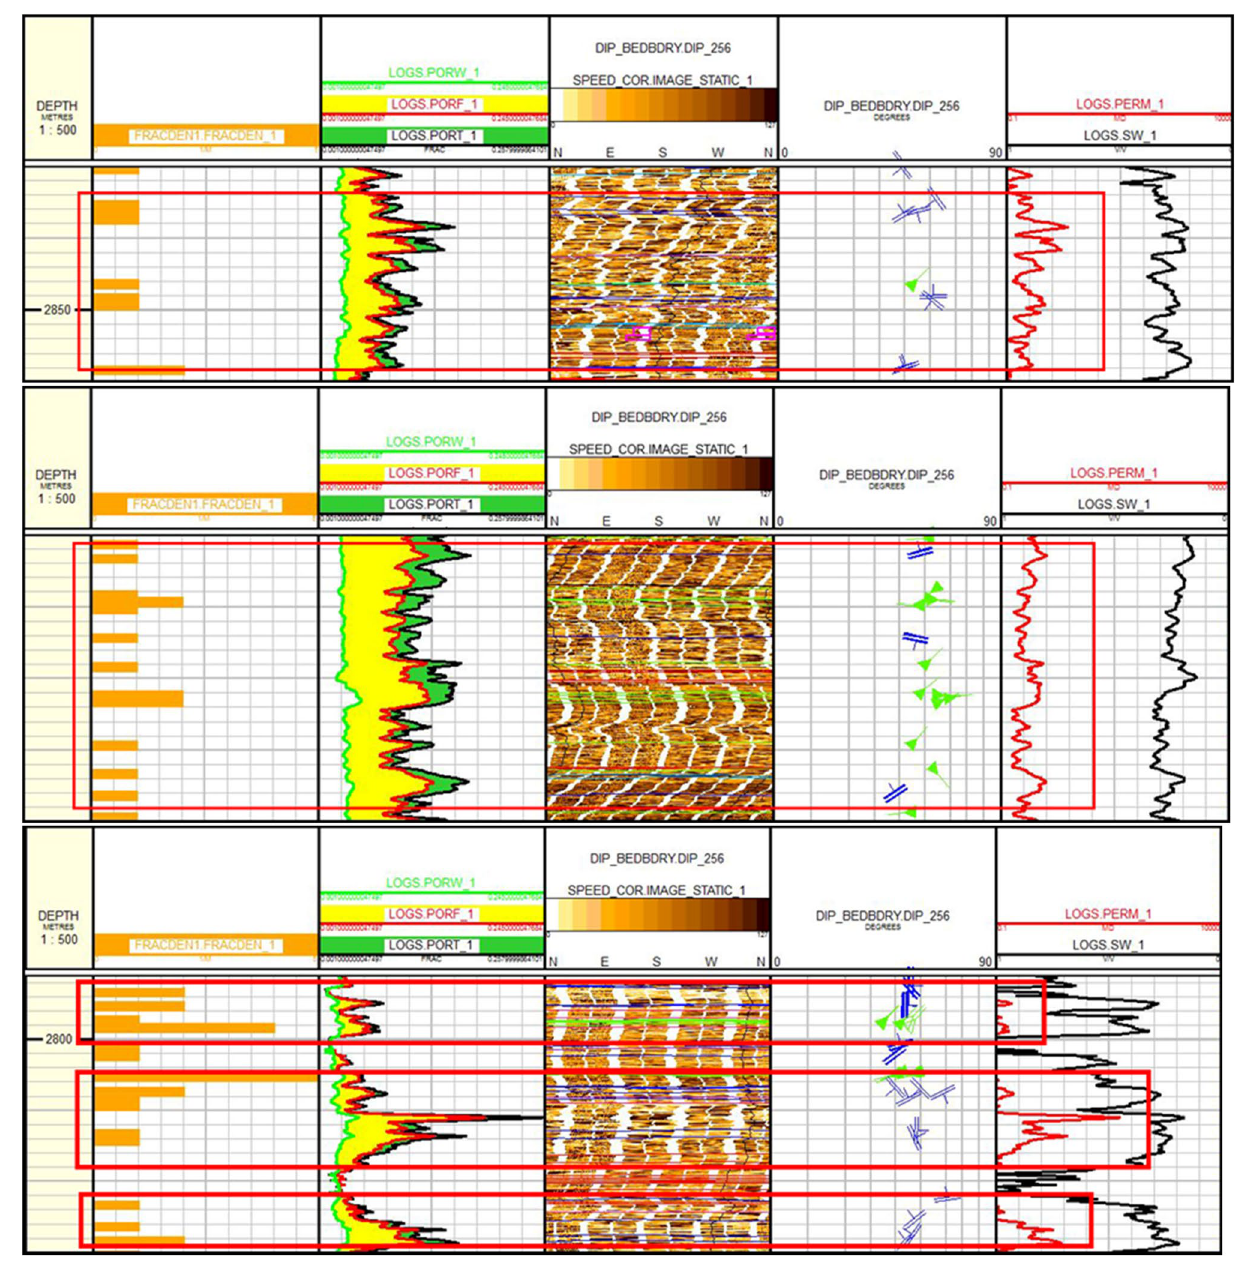
Fig. 13 Permeability variation wit fracture density in fractured